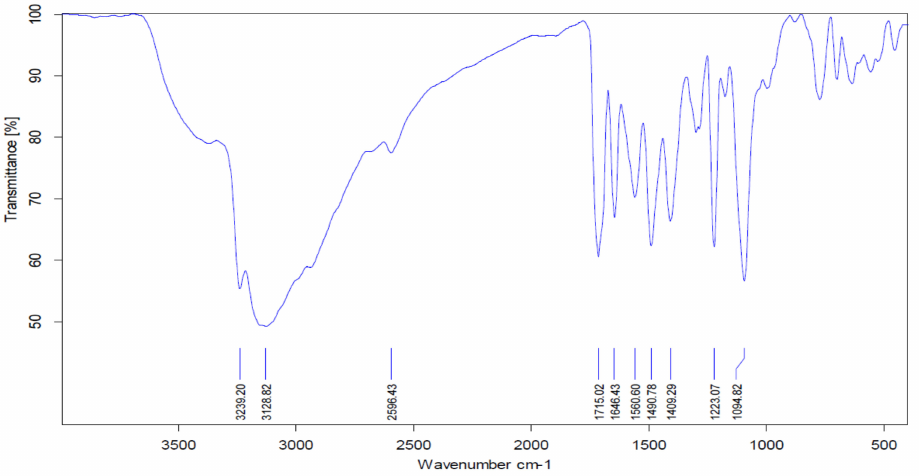
Figure 3. IR spectrum of Tyr-Cu(II)-AEEA